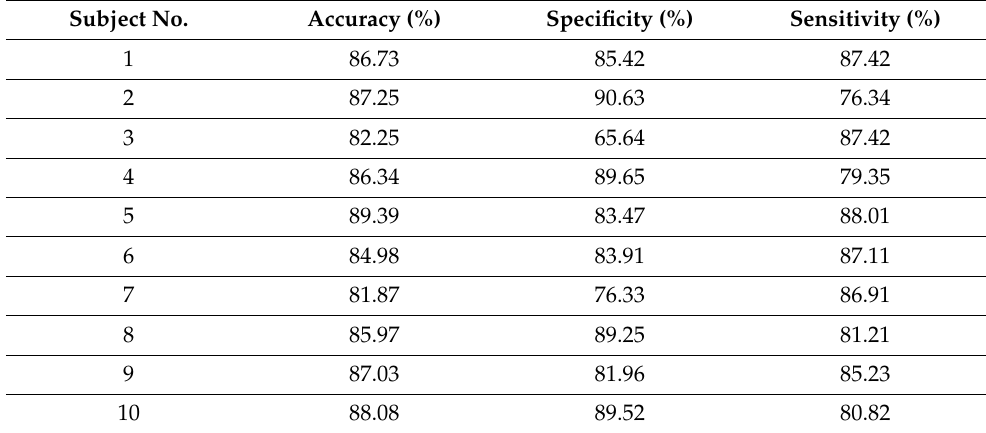
Table 4. Comparison of results obtained by system and medical